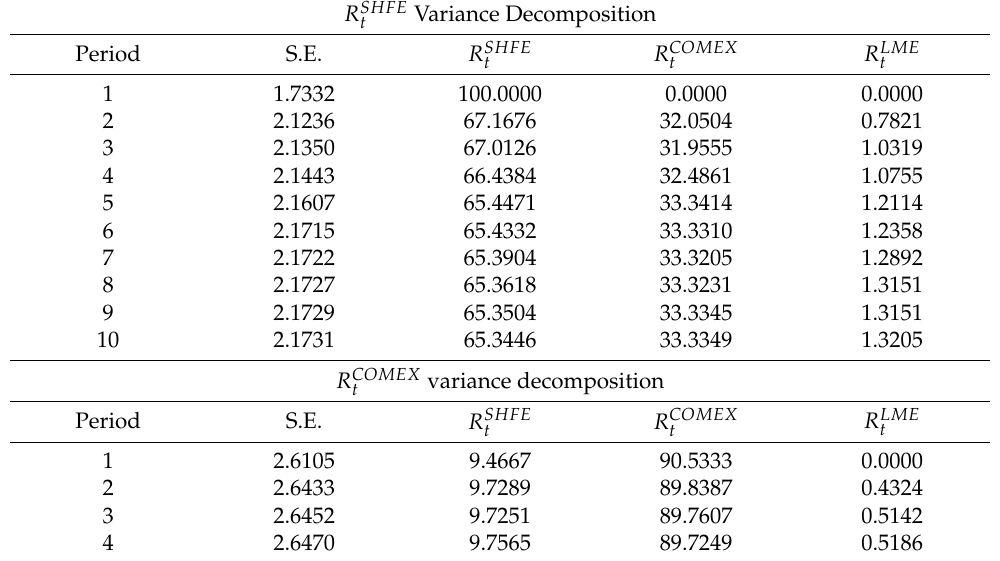
Table 5. Variance decomposition of logarithmic return rate of copper futures in three markets in the first stage.